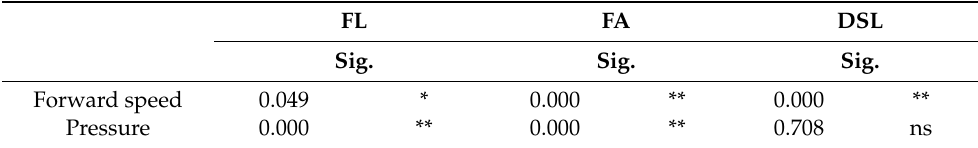
Table 3. ANOVA of the length of the liquid starter fertilizer (FL), the amount of the liquid starter fertilizer (FA), and the distance between the seeds and the liquid starter fertilizer (DSL). FL FA DSL Sig. Sig. Sig. 0.049 0.000